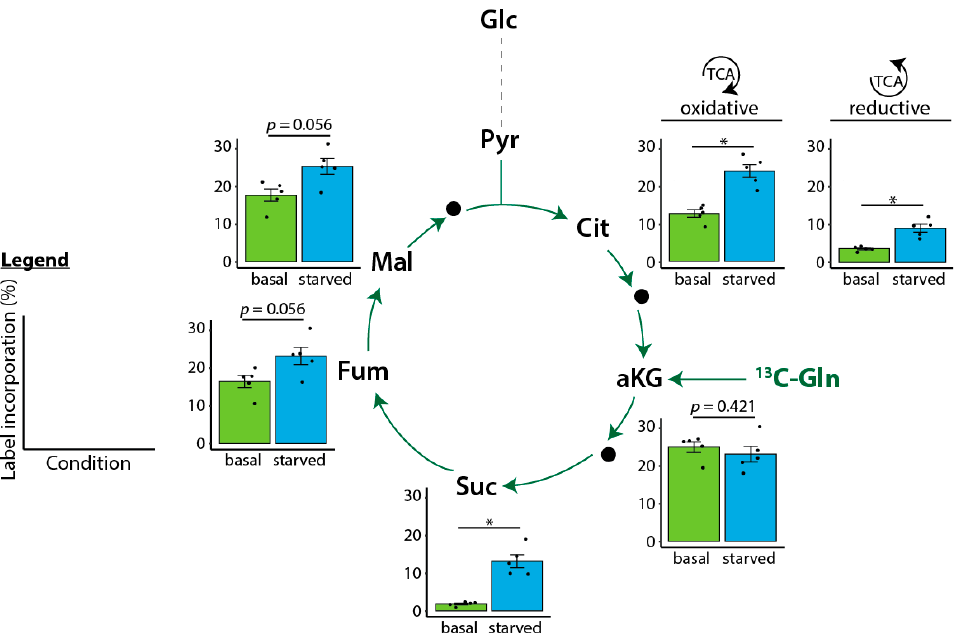
Figure 3. Incorporation of central carbon metabolites after labeling with 13 C-glutamine (Gln) for 3 h. Bar charts present the individual values and the means ± SEM of the label incorporation (in %). Significance was calculated using the Mann–Whitney U test. Significance levels are * p < 0.05 or as indicated. HUVECs from n = 5 different donors. Abbreviations (from top to bottom): Glc: glucose. Pyr: pyruvic acid. Cit: citric acid. Mal: malic acid. Fum: fumaric acid. aKG: alpha-ketoglutaric acid. Gln: glutamine. Suc: succinic acid.